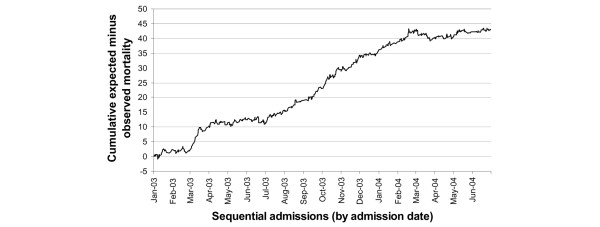
Cumulative expected minus observed mortality chart. Probability of death estimated with UK APACHE, Royal Berkshire Hospital, 1 January 2003 to 30 June 2004.